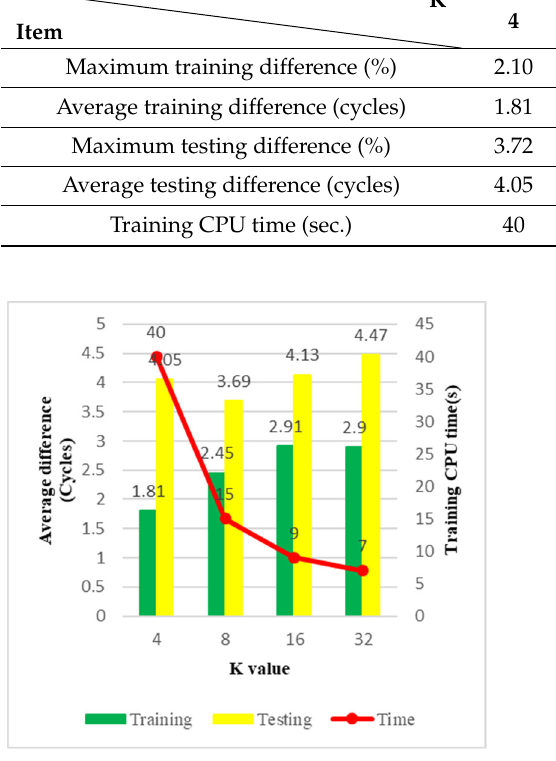
Table 16. The performance of the K-K model.